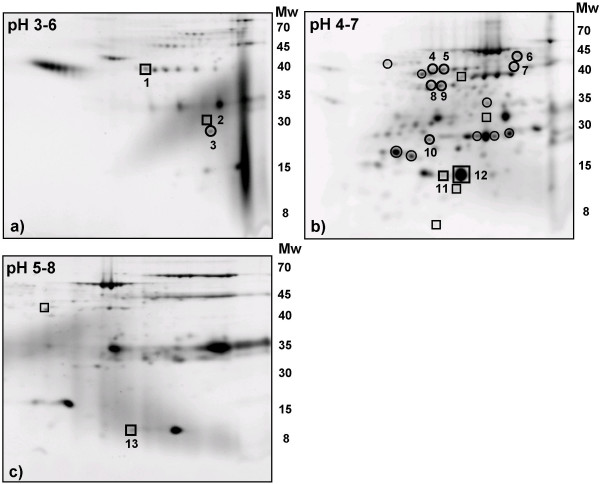
Prefractionated CSF from FTD patients compared to non-demented controls. Protein densities increased (squares) or decreased (circles) at least two times in prefractionated FTD CSF, analyzed using SYPRO-Ruby stained 2-DE gels. The five FTD patients were 70.6 ± 5.6 (mean ± SD) year-of-age and the five non-demented controls were 59.2 ± 11.9 (mean ± SD) year-of-age. The numbers on the 2-D gel pattern correlate each identified protein to the data given in table 2. Molecular weights (MW) are in kDa. a) Fraction 2–5 with pH 1.5–4.5 was analysed using a pH 3–6 linear IPG-strip. b) Fraction 6–9 with pH 4.5–6.0 was analysed using pH 4–7 linear IPG-strip. c) Fraction 10–14 with pH 6.0–7.5 was analysed using pH 5–8 linear IPG-strip in the first dimension.